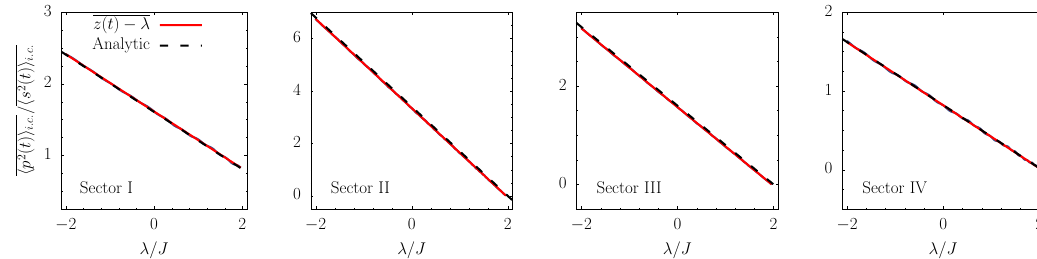
Figure 9: Test of the harmonic Ansatz with dynamic data. N = 1024 system with = 1.5 J parameters in the four phases of the phase diagram: in phase I, T and 0 0 = 1.5 J = 0.5 J J = 0.4 J ; in phase II, T and J = 1.7 J ; in phase III, T and 0 0 0 0 0 0 = 0.5 J J = 0.8 J ; and finally in phase IV, T and J = 0.4 J . λ are the post- 0 0 0 0 quench harmonic constants and they are normalised by J in the horizontal axes letting them all vary between − 2 and 2. The dashed black lines are the analytic − λ = T + J 2 / T − λ (I and IV) and z − λ = 2 J − λ (II and III), while predictions z f f 0 0 the red lines are the numerical solution to the dynamic equations.